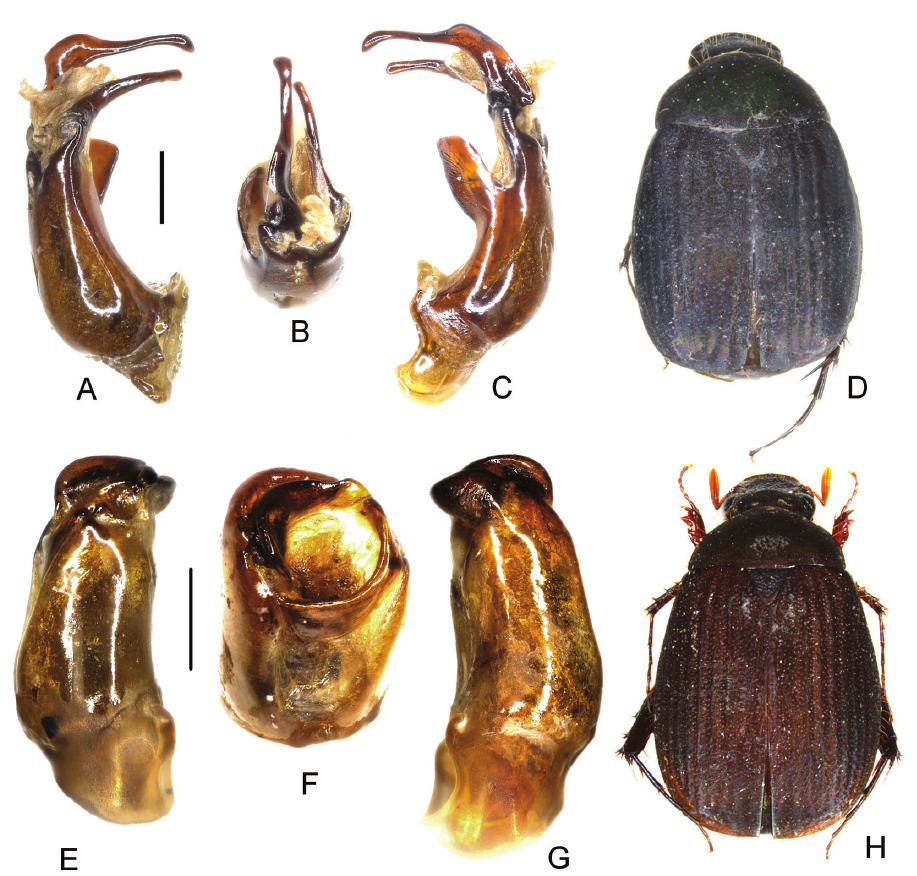
Figure 4. A–D Neoserica tahianensis Ahrens, Fabrizi & Liu, sp. n. (holotype) E–H N. silvestris Brenske (China: Nu Shan) A, E aedeagus, left side lateral view C, G aedeagus, right side lateral view B, F para- meres, dorsal view D, H habitus. Scale bars: 0.5 mm. Habitus not to scale. Diagnosis. Neoserica tahianensis Ahrens, Fabrizi & Liu, sp. n. is in external ap- pearance and genital morphology similar to N. obscura and N. allobscura . Neoserica tahianensis differs by the large ventral process of the phallobase and by the shape of its parameres: the right paramere is slightly longer than in N. obscura , the left one does not possess a dorsal